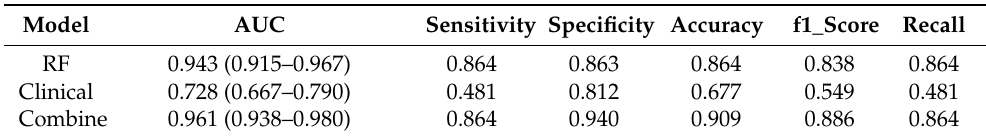
Table 5. Model performance of the best radiomics model, clinical model and combined model in internal training